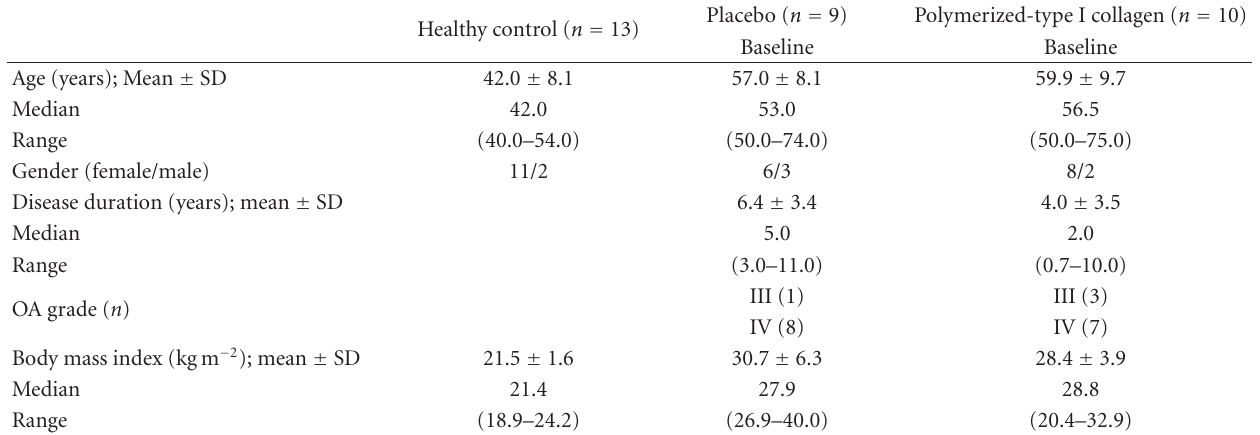
Table 1: Demographic characteristics of the